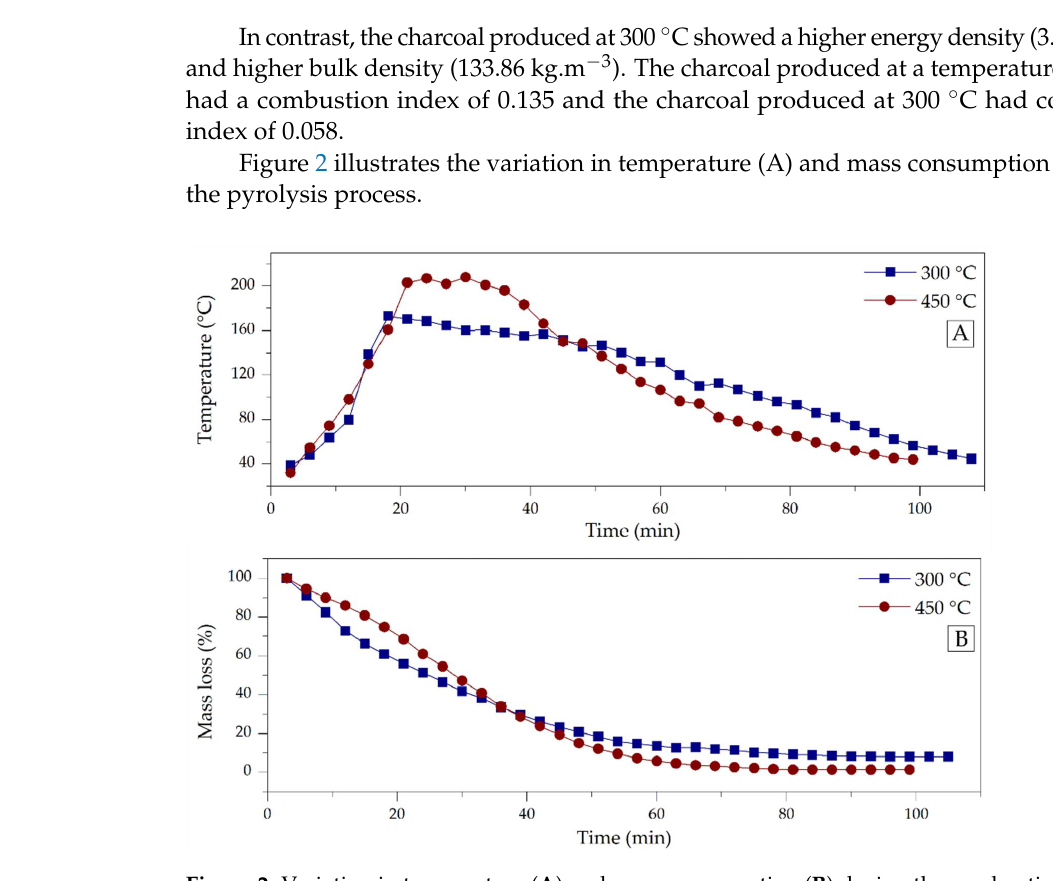
Figure 2. Variation in temperature ( A ) and mass consumption ( B ) during the combustion